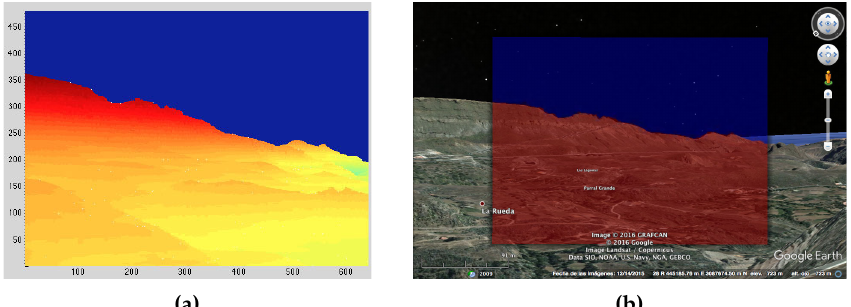
Figure 2. Synthetic image alignment test with known landmarks. ( a ) Synthetic image after manually applied pitch, roll, and yaw corrections. ( b ) Synthetic image superimposed on Google Earth.